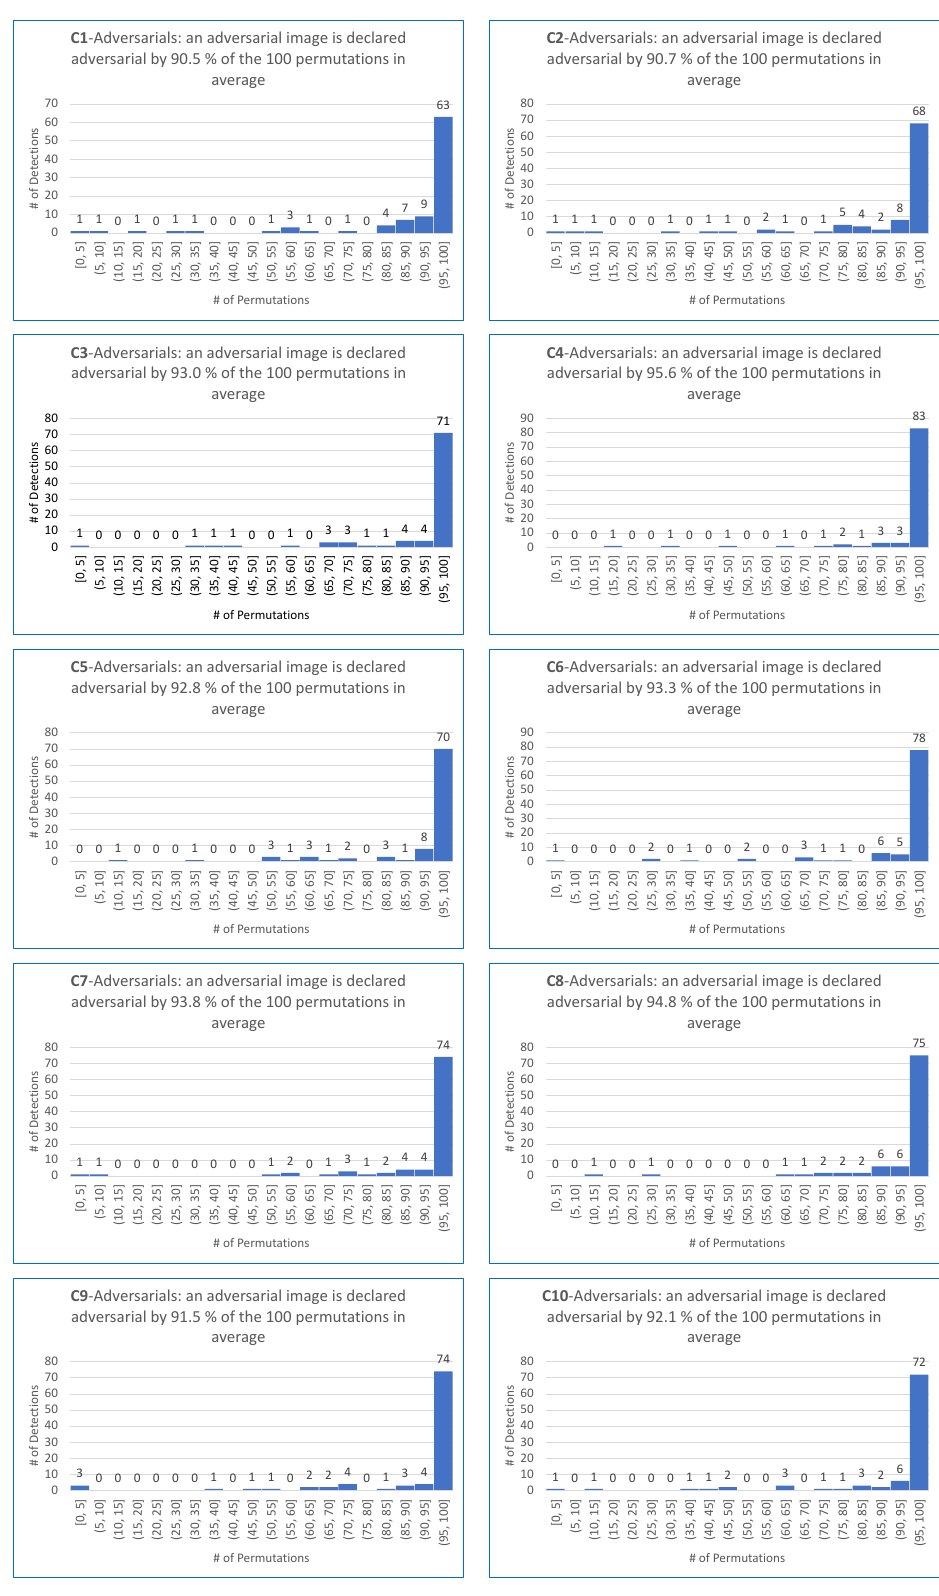
Figure A13. ShuffleDetect results for adversarial images generated by the Deep Fool-untargeted attack on C = C for 1 ≤ k ≤ 10 over 100